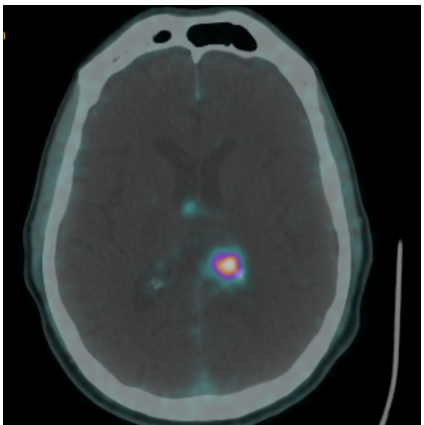
Figure 3. [ 68 Ga]Ga-DOTATOC PET/CT scan showing a left intraventricular lesion with high tracer uptake in a patient with a history of carcinoid. GK treatment was planned by contouring the margins of the lesion with tracer uptake.